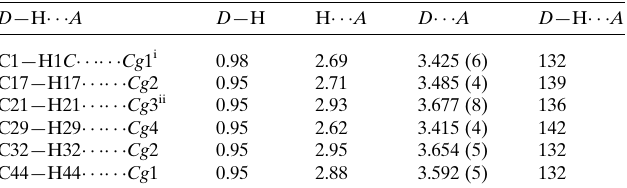
Table 2 Hydrogen-bond geometry (A˚ , (cid:5) ). Cg 1, Cg 2, Cg 3 and Cg 4 are the centroids of the C33–C38, C39–C44, C52–C57 and C19–C24 rings, respectively.